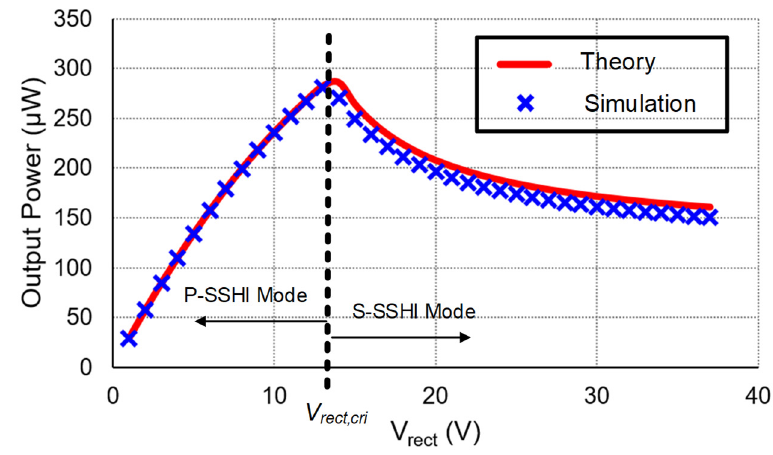
Figure 9. Comparison of theoretical results with simulation results.